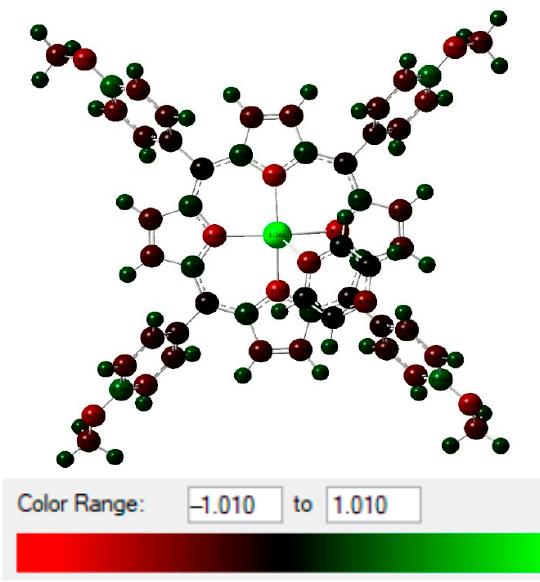
Figure 9. NBO total charge distribution (in unit of electron) of ( 1 ).